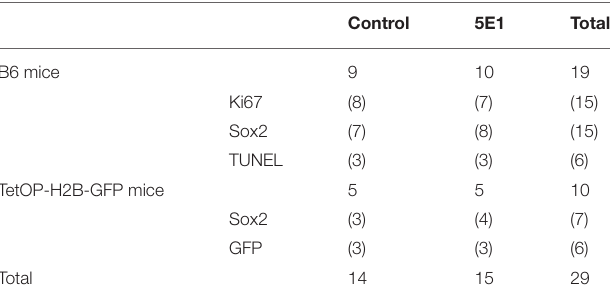
TABLE 2 | Number of incisor explants for histological, immunohistochemical, and statistical analyses of Ki67-, Sox2-, TUNEL, and GFP-positive cells. Control